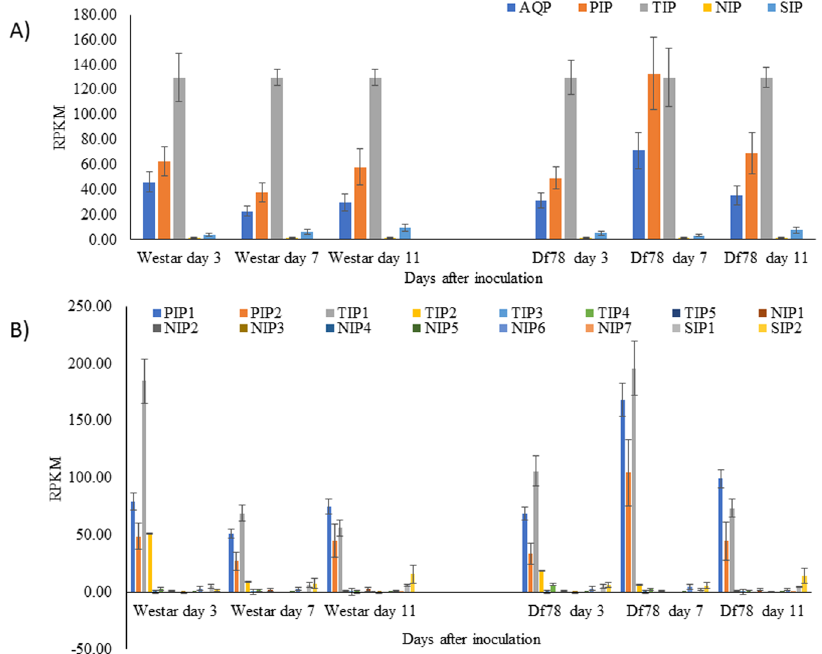
Figure 7. Expression of Brassica napus AQP in susceptible and resistant genotypes after inoculation with Leptosphaeria maculans retrieved from Bioproject PRJNA311316. Graphs are showing expression level in term of average reads per kilobases of transcript per million mapped reads (RPKM) for ( A ) four AQP subfamilies namely PIP, Plasma membrane intrinsic protein; TIP, Tonoplast intrinsic protein; NIP, Noduline-26 like intrinsic protein; SIP, Small intrinsic protein; and ( B ) groups in the each subfamily. Bars represent standard error from the mean for all values within a subfamily or a group out of three biological replicates. Detailed data are provided in Supplementary Dataset